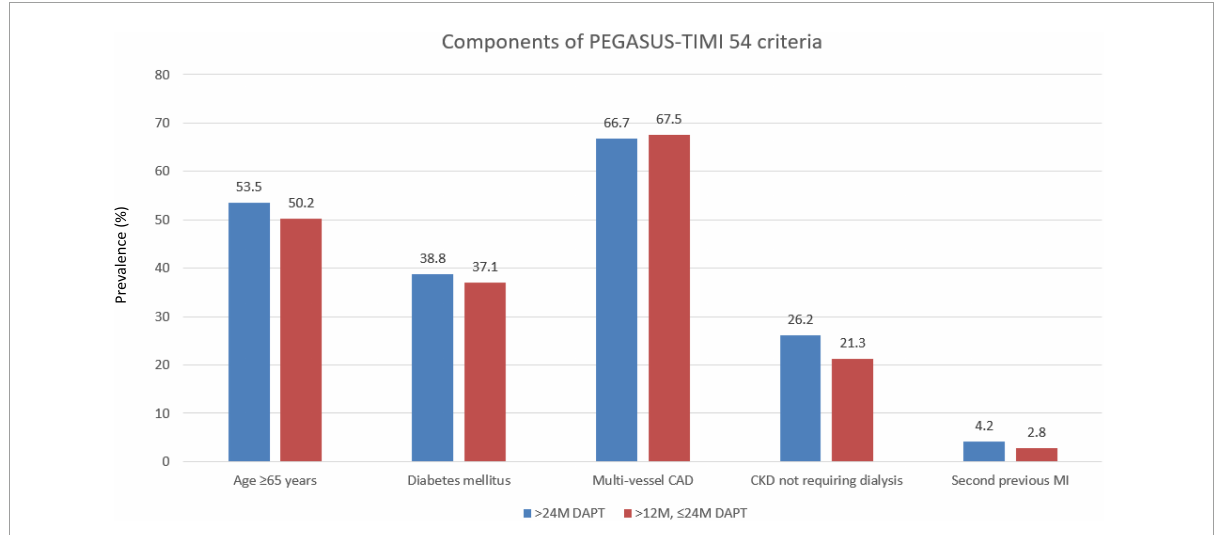
FIGURE2 Prevalence of the individual qualifying variables within the “with PEGASUS-TIMI 54 criteria” group. CAD, coronary artery disease; MI, myocardial infarction.